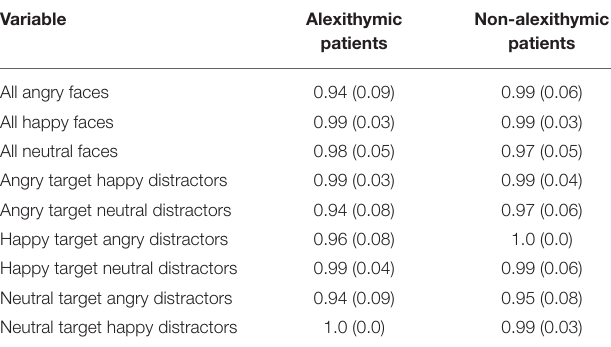
TABLE 2 | Rate of correct non-responses/responses as a function of alexithymia, emotional quality of target, and distractor face and target absence/presence [means and SD (in